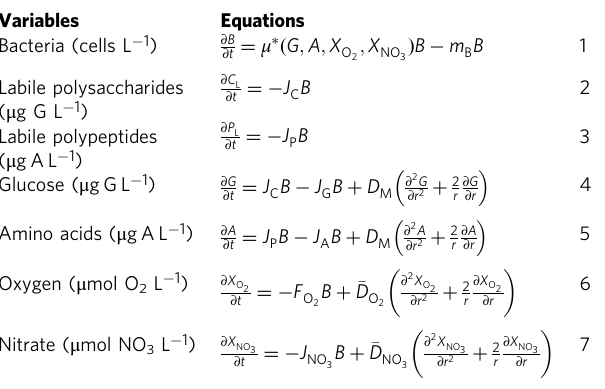
Table 1 Equations for the particle model. Variables Equations Bacteria (cells L − 1